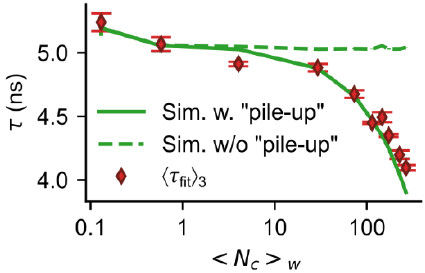
Figure 7. Impact of the detector’s pile-up on the FL. Lifetime vs. count rate (cid:104) N c (cid:105) w . Experimental FL measurements (red markers) and Monte Carlo simulations (green curves) for a SPAD array detector show that at lower (cid:104) N c (cid:105) w values the lifetime stays relatively constant. At higher (cid:104) N c (cid:105) w values the impact of detector’s pile-up (explained in Figure 1(Cii)) leads to an increasingly underestimation of the lifetime (difference between Monte Carlo simulation with pile-up (green solid curve) to the respective simulation without pile-up (green dashed curve)).